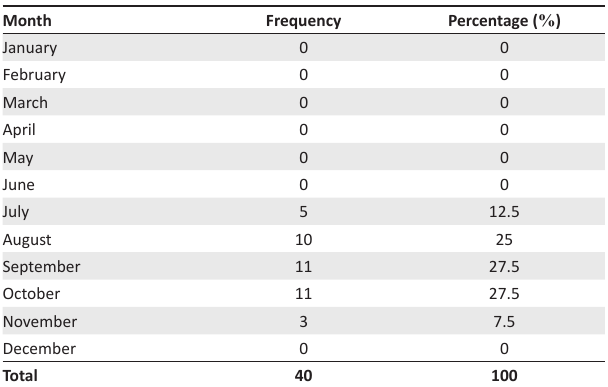
FIGURE 5: Major causes of veld fires in Mangwe District. TABLE 2: Months in which veld fires are most